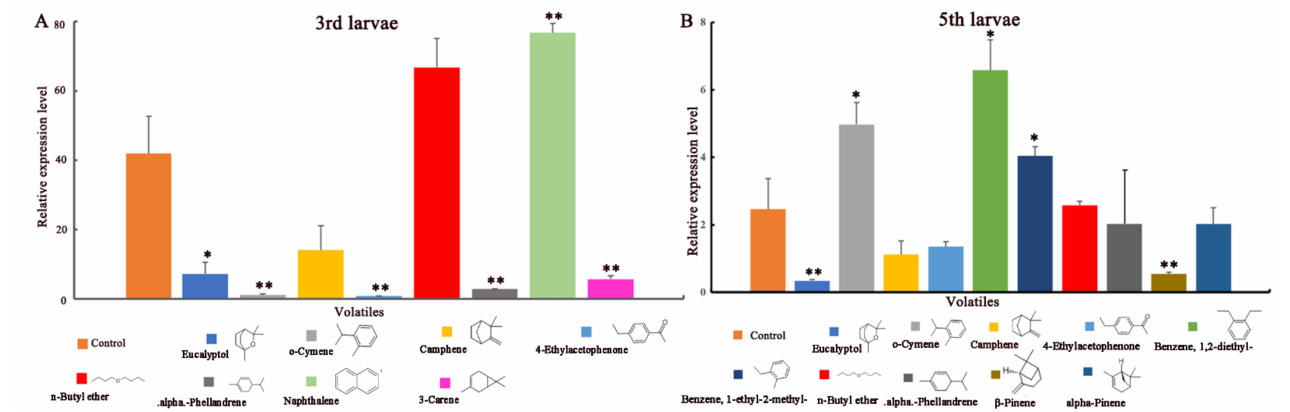
Figure 1. Expression profile of EsigGOBP1 in E. signifer larvae from exposure to key volatiles. ( A ) 3rd instar larvae; ( B ) 5th instar larvae. The standard errors are represented by the error bars, * and ** above the bars denote significant differences at p < 0.05 and p < 0.001